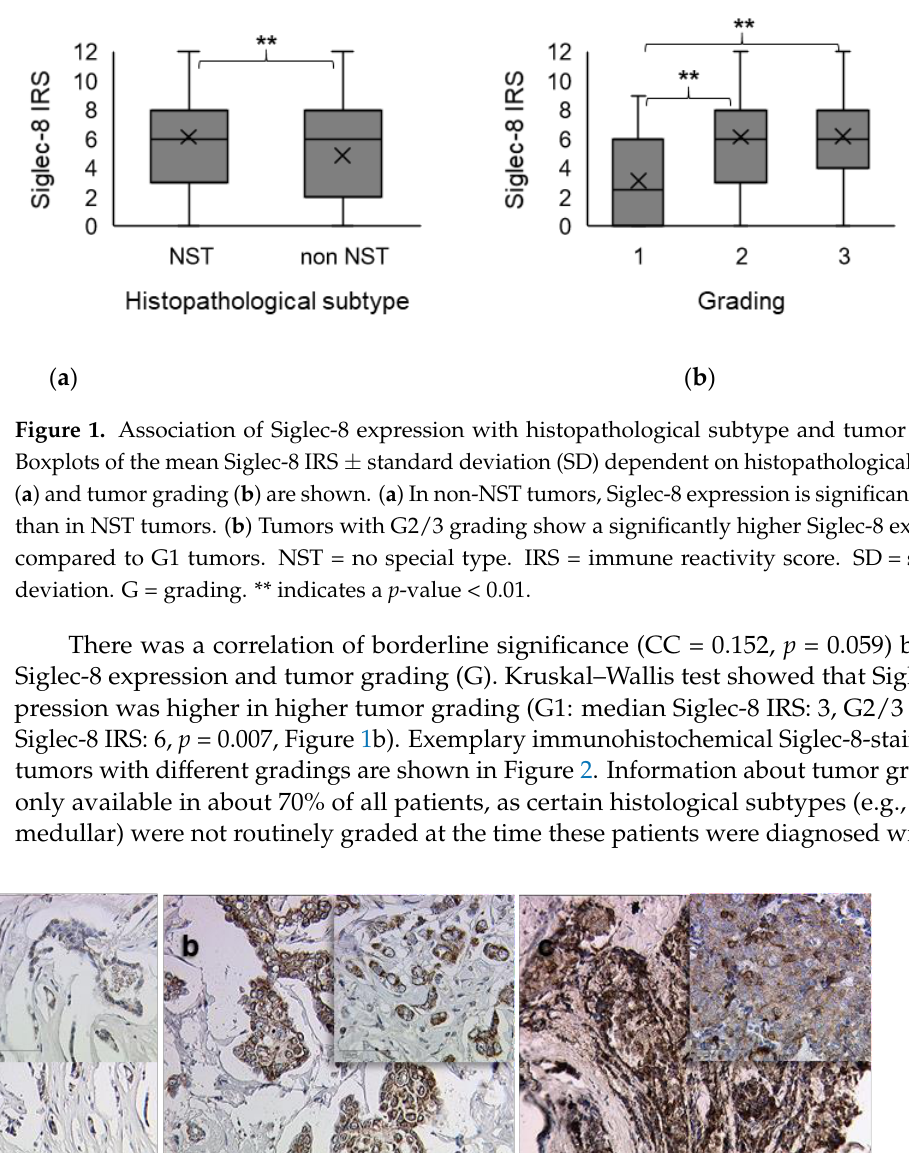
Figure 2. Siglec-8 expression dependent on tumor grading. Exemplary immunohistochemical staining results of Siglec-8 in grade 1 ( a ), 2 ( b ) and 3 ( c ) breast cancer are shown. Magnification: main images ×10, image sections ×25.